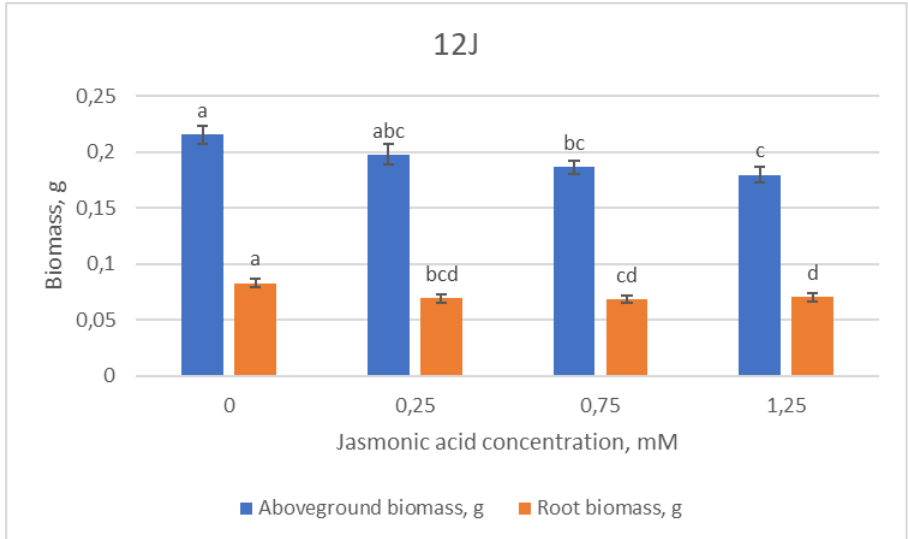
Figure 3. Means (g) ± SE of above-ground and root biomass of Scots pine half-sib family 12J, measured 6 weeks after sowing. Data significance was calculated using the Kruskal–Wallis H test for ranks and post hoc Dunn’s test for pairs ( p < 0.05). Different letters next to different colors indicate significant differences between the groups, sprayed with different concentrations of jasmonic acid.